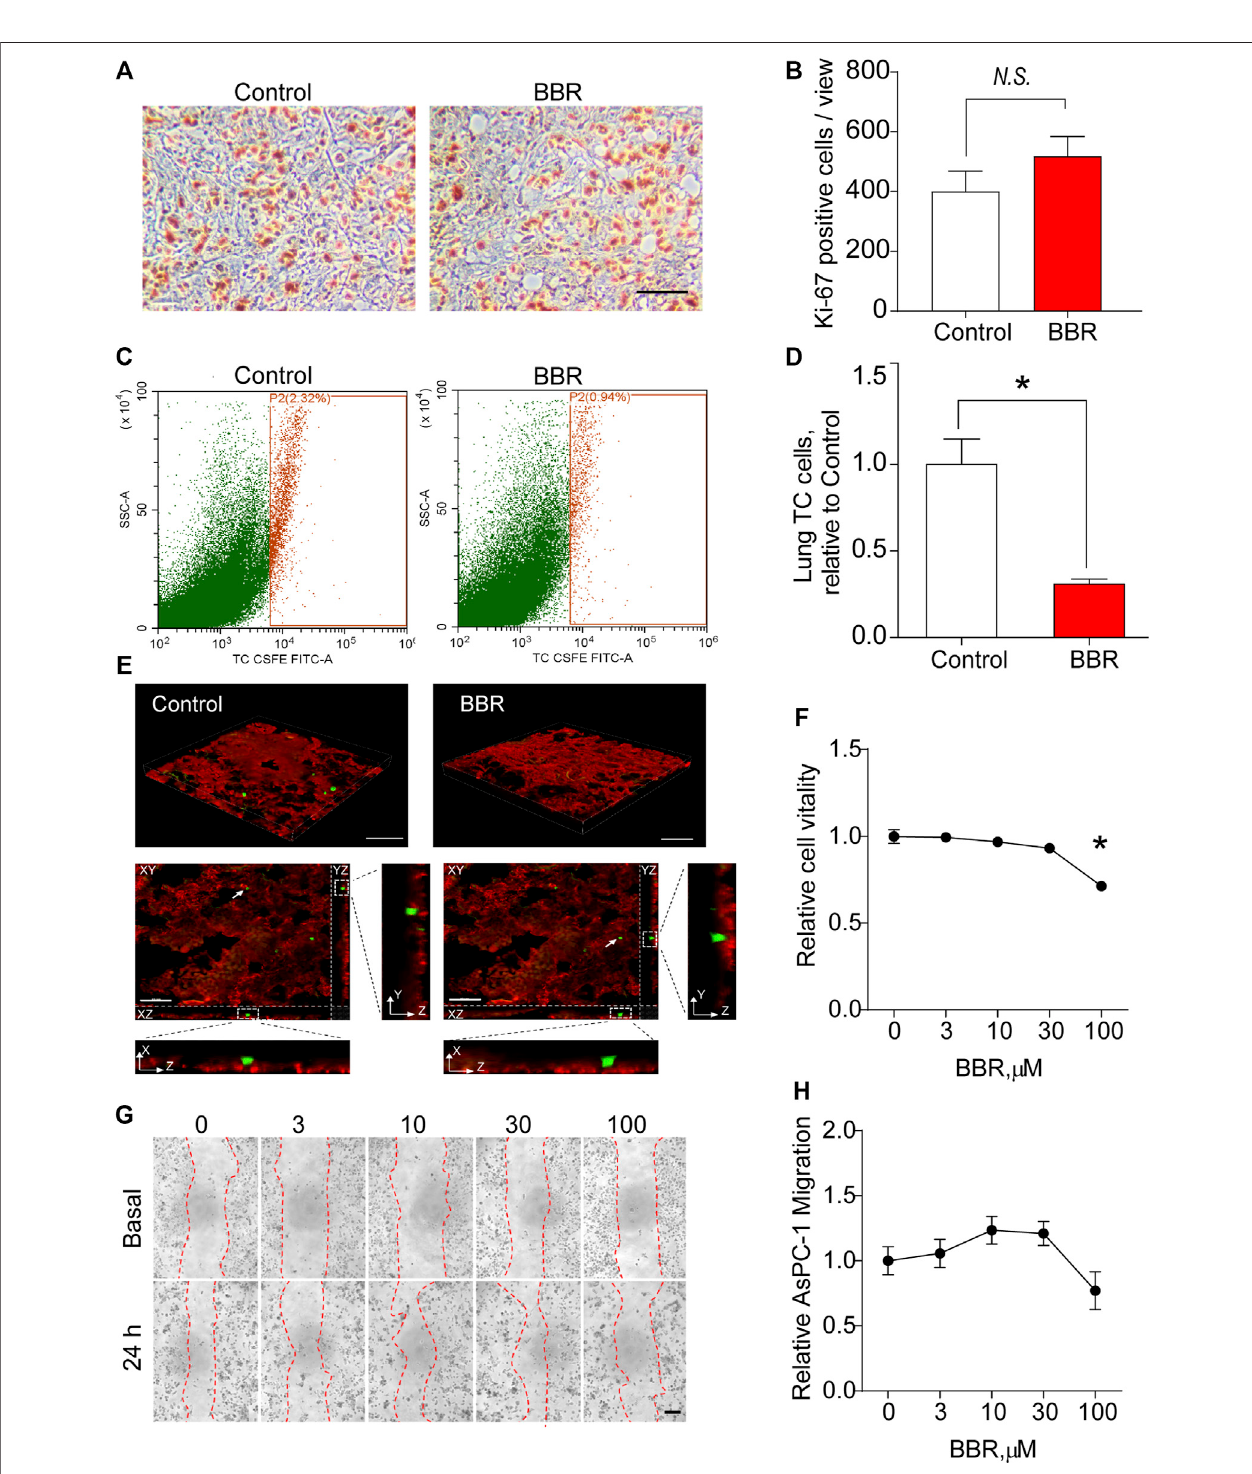
FIGURE2| BBRinhibitslungin fi ltrationofPCcells(AsPC-1). (A,B) .Representativeimages (A) andstatisticalresults (B) oftheKi-67stainingoflungmetastaticfoci. Scale bar = 100 μ m. (C,D) Representative images (C) and statistical results (D) of the fl ow cytometric analysis of lung in fi ltration of circulating cancer cells 24 h after the intravenous injection of CFSE-labeled AsPC-1 cells in the control or BBR-pretreated groups. (E) 3D reconstruction fl uorescence images of mice lung tissue section dissected24 hpost-intravenousinjectionofCFSE-labeledAsPC-1cellsincontrolorBBR-pretreatedgroups.LowerpanelsshowedXZandYZviewsoftwotumor cells indicated by white arrows. Red: vasculature, green: CFSE-labeled AsPC-1 cells. Scale bar = 100 μ m in upper panels, and 50 μ m in lower panels. (F) Effect of BBR treatment for 24 h on the proliferation of AcPC-1 cells in vitro . (G,H) . Effect of treating AcPC-1 cells with BBR for 24 h, on the migration (G) ; representative images; (H) , statistical results) of AsPC-1 cells. Scale bar = 20 μ m * p < 0.05; n = 4 in (B,D) , t -test; n = 6 in (F,H) , one-way ANOVA with Dunnett ’ s multiple comparisons test.